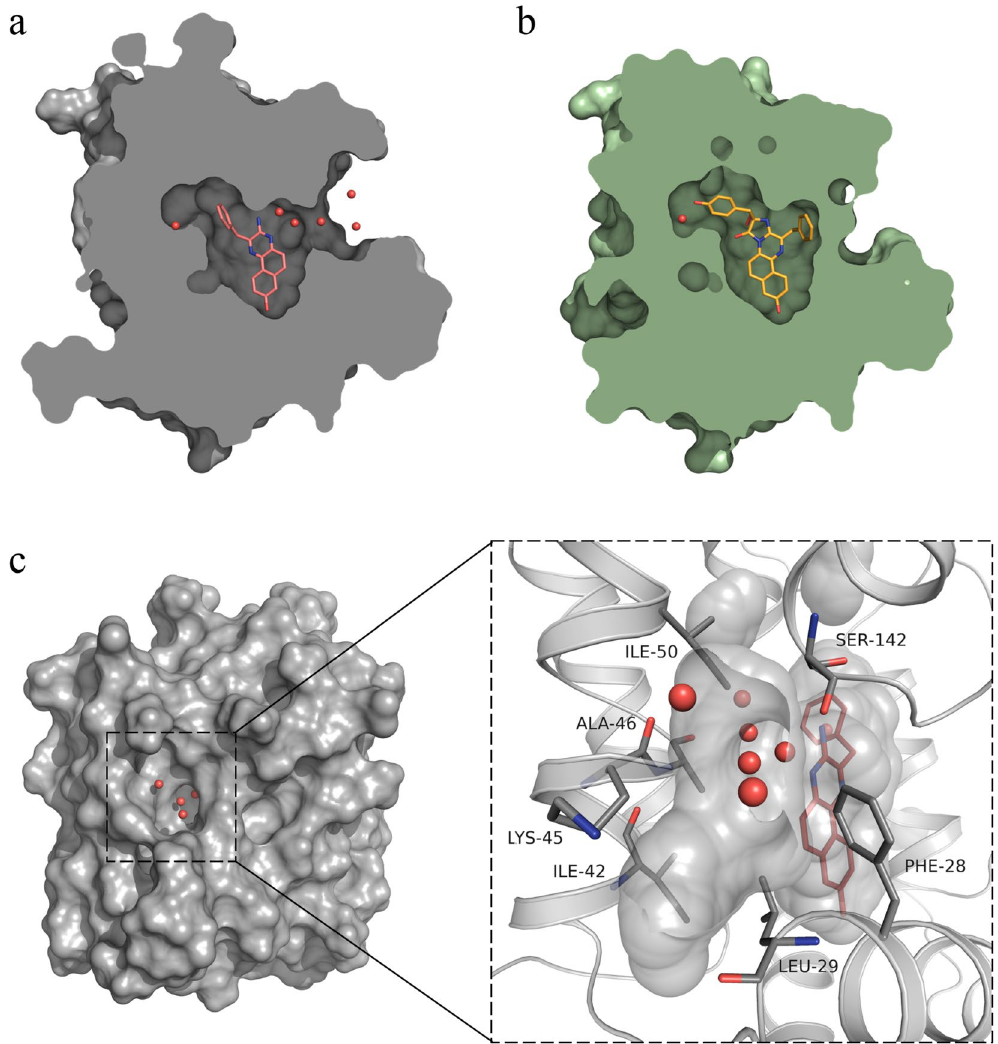
Figure 3. Molecular-surface representation of obelin- v . CTM- v ( a ) and 2-hydroperoxyCTZ- v ( b ) molecules within the substrate-binding cavities of the corresponding obelin- v structures: Ca 2+ -discharged obelin- v (gray, PDB: 8A9S) and active obelin- v (green, PDB: 7O3U). CTM- v and 2-hydroperoxyCTZ- v molecules are colored in red and yellow, respectively. Both structures are in the same orientation. ( c ) Ca 2+ -discharged obelin- v (8A9S, chain B) with a solvent-exposed opening on the surface shown in the center. (( c ), insert) Detailed representation of the solvent-exposed opening and the ligand-binding pocket with the CTM- v and water molecules. The CTM- v and amino acid residues surrounding the solvent-exposed opening are respectively shown as stick models of red and grey colors. Water molecules are represented as red